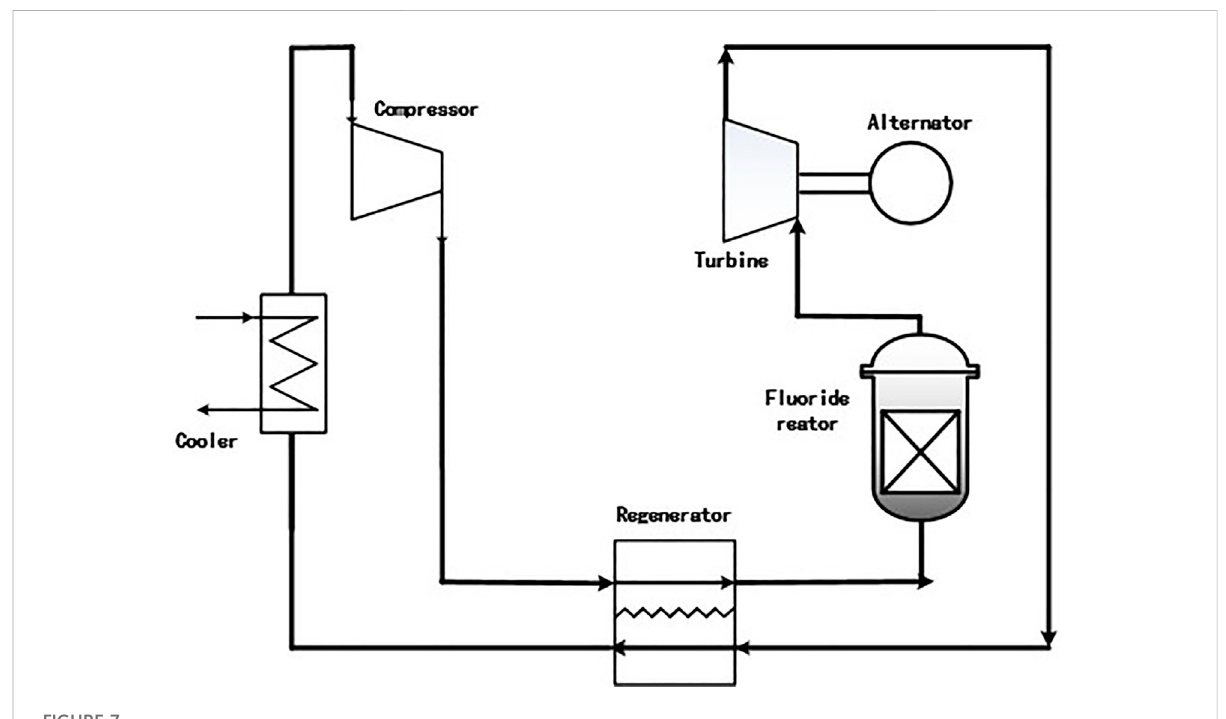
FIGURE 7 Flow chart of the simple regenerative cycle.